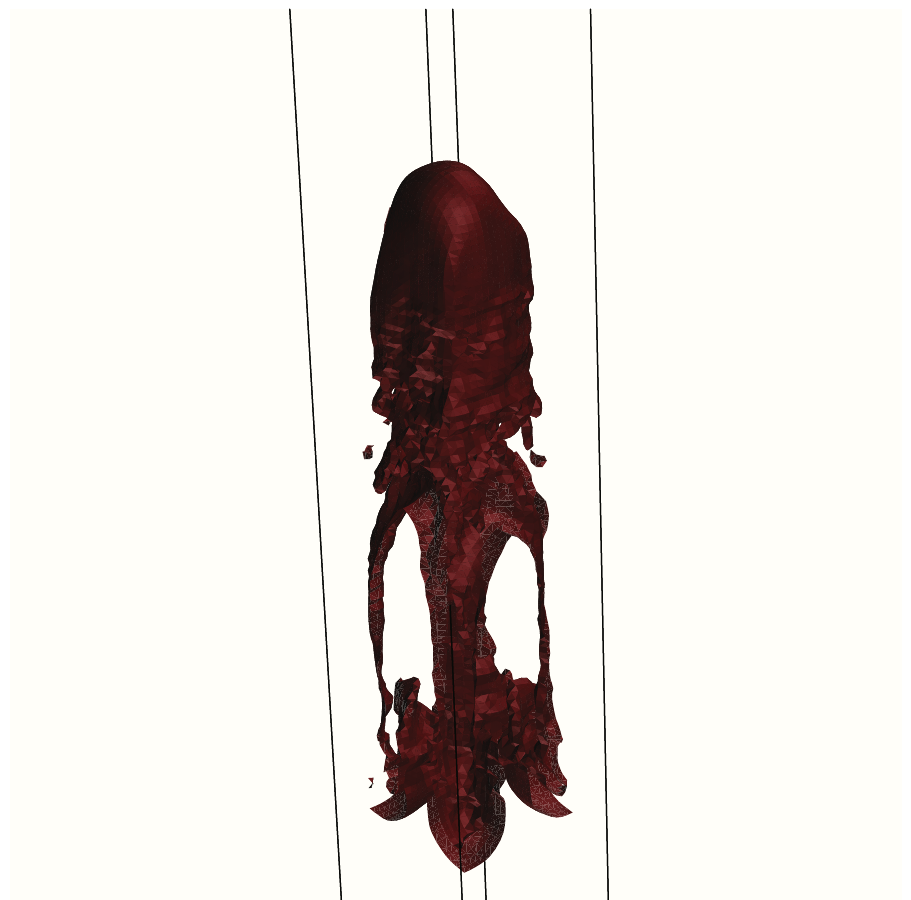
Figure 5: Plot of late time for Rayleigh-Taylor fl uid instability. Flow and grid parameters as in Figure 2.